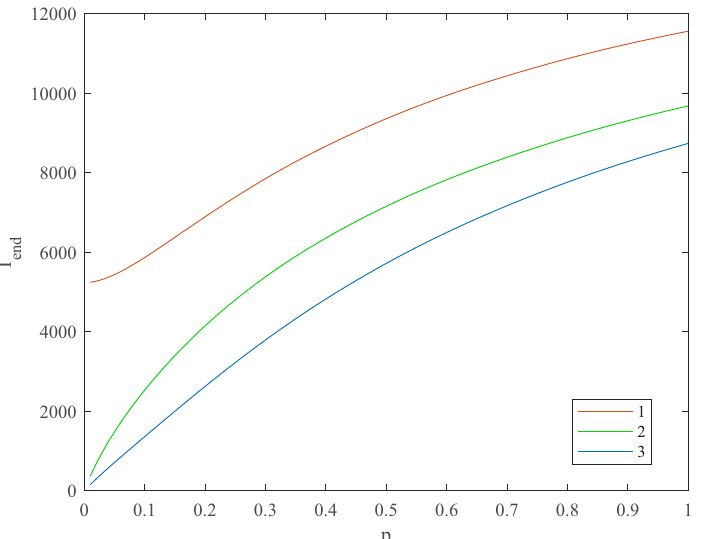
Figure 4. The dependence of the final number of infected in districts (red—1, green—2, blue—3) on the degree of openness of the boundaries between the hub and other districts